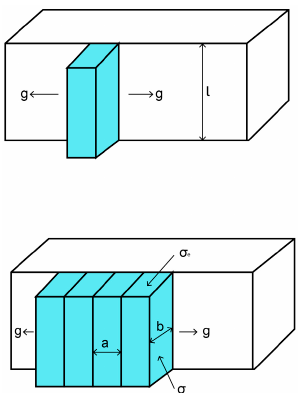
Figure 3. The Hoffman–Lauritzen model with stems of width a, depth b, and height l. The surface free energy on fold and lateral surfaces are σ e and σ , respectively. The lateral growth rate is g.